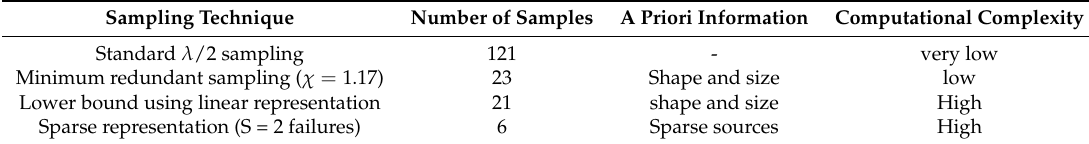
Table 1. Comparison between sampling techniques for the measurement geometry used in the examples reported in this